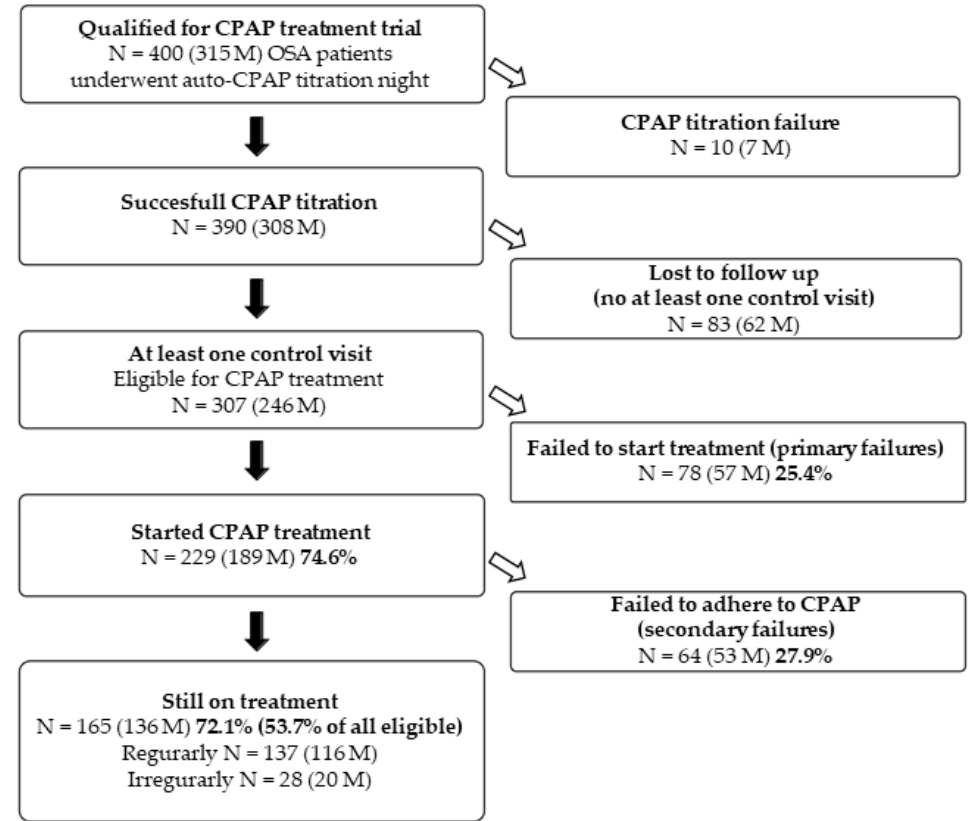
Figure 1. Flow chart of the study. CPAP—continuous positive airway pressure, M—male, N—number, OSA—obstructive sleep apnoea/hypopnoea syndrome.